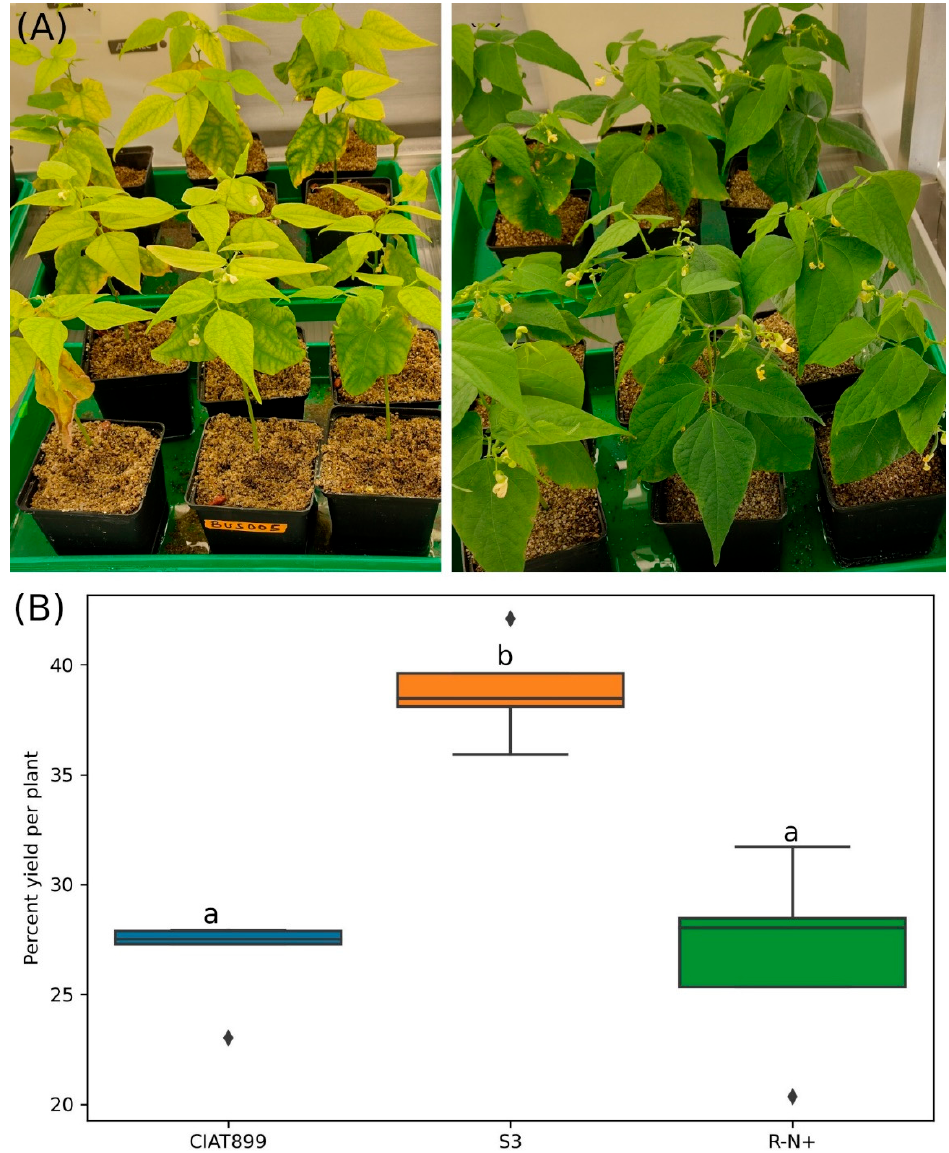
Figure 2. Common bean plants treated with 300 mM NaCl; ( A ; left panel) were not inoculated while ( A ) right panel) were inoculated with isolate S3, ( B ) Yields [(shoot dry weight of salt-treated plants/shoot dry weight of untreated control plants) × 100]. CIAT899: plants inoculated with R. tropici CIAT899, S3: plants inoculated with isolate S3, and R-N+: uninoculated plants supplied with nitrogen. The horizontal lines inside the boxes show the median percent yields, the diamonds ( (cid:7) ) represent outlier values while significantly different yield percentages are indicated by different letters above the boxes (one-way